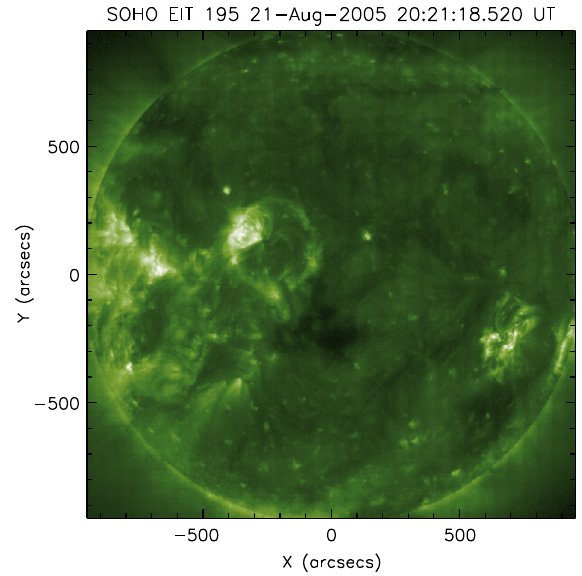
Fig. 1. SOHO/EIT 195 Å image showing two solar anemones, AR 10798 (centered around coordinates [700, (cid:3) 300]) and AR 10800 (circular shaped, located around coord. [200, 100],